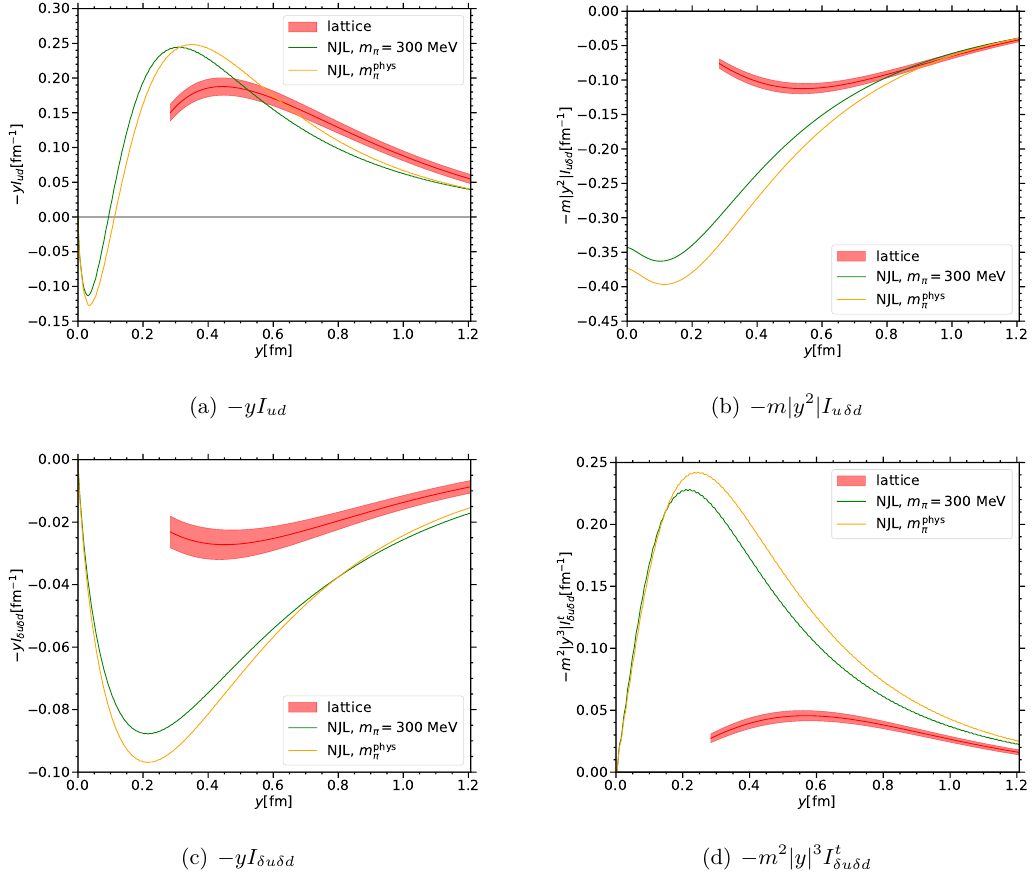
Figure 33 . Comparison of our results for Mellin moments I ( y, ζ = 0) of DPDs in a π + with those obtained with the Nambu Jona-Lasinio model in [60]. The lattice results correspond to the ones in our figure 31(a) but are multiplied by an additional factor − y . The model curves for m phys same as the ones labelled “PV” in figure 3 of [60]. The lattice and model results refer to different factorisation scales, as specified in the